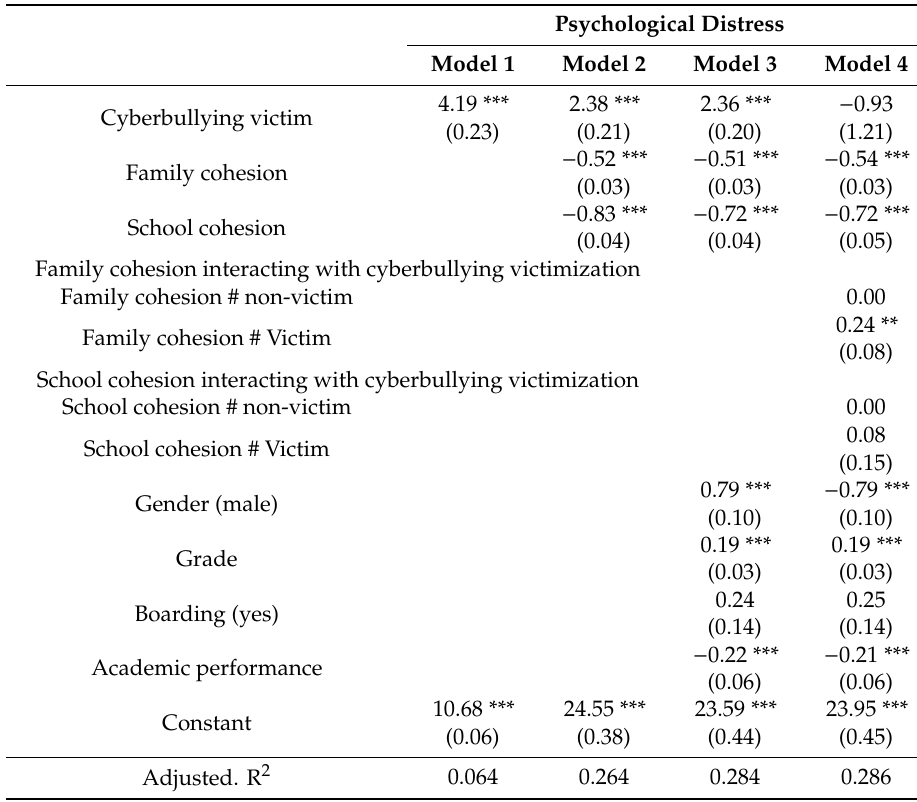
Table 2. Cyberbullying victimization and psychological distress with moderating e ff